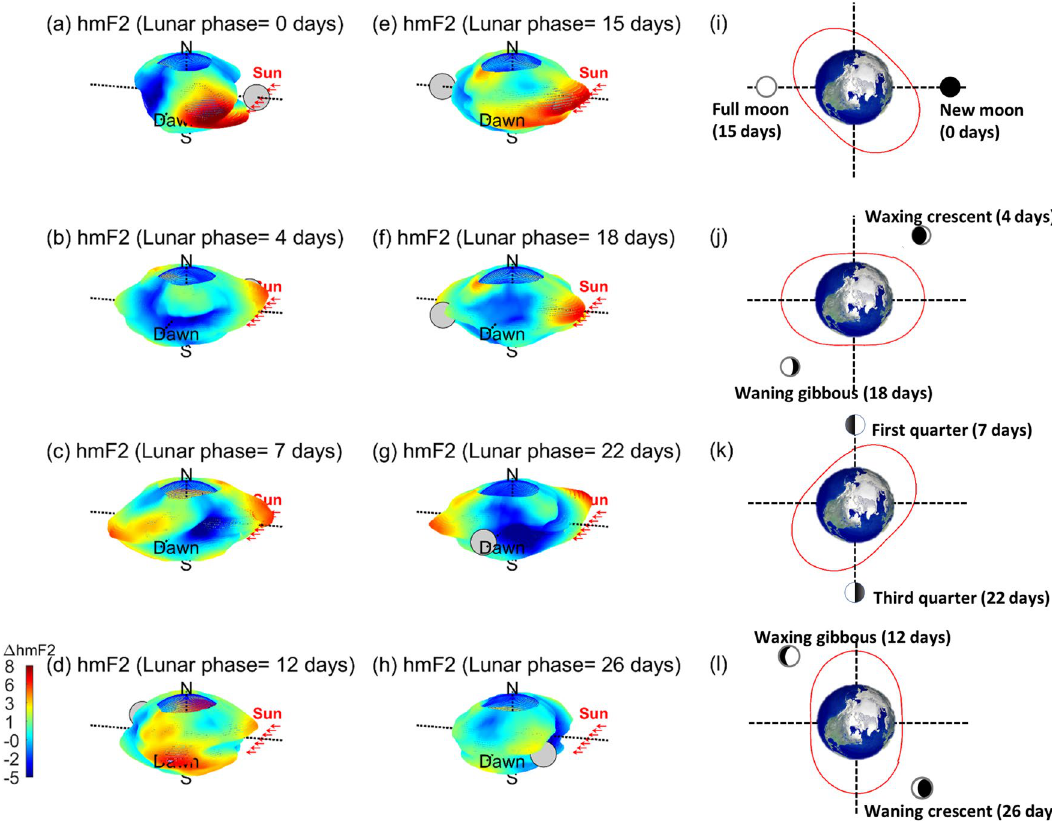
Figure 2. Global composite hmF2 during lunar phases of the ( a ) new moon (0 days), ( b ) waxing crescent (4 days) ( c ) first quarter (7 days), ( d ) waxing gibbous (12 days), ( e ) full moon (15 days), ( f ) waning gibbous (18 days), ( g ) third quarter (22 days), and ( h ) waning crescent (26 days). ( i–l ) Sketches of hmF2 on the equatorial plane on the 0/15, 4/18, 7/22, and 12/26 days. The red ellipse denotes the meridional averaged hmF2. The gray circle denotes the Moon